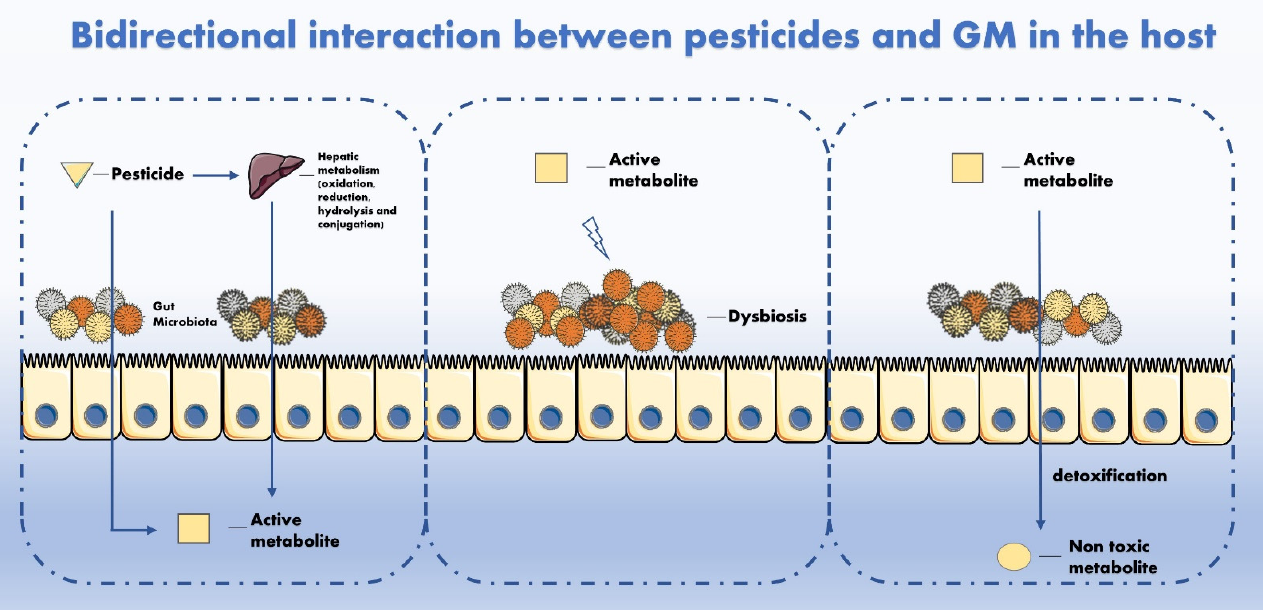
Figure 1. GM metabolizes multiple chemicals after intake. Mutually, pesticides can impair GM activity and composition with adverse repercussion for the host.